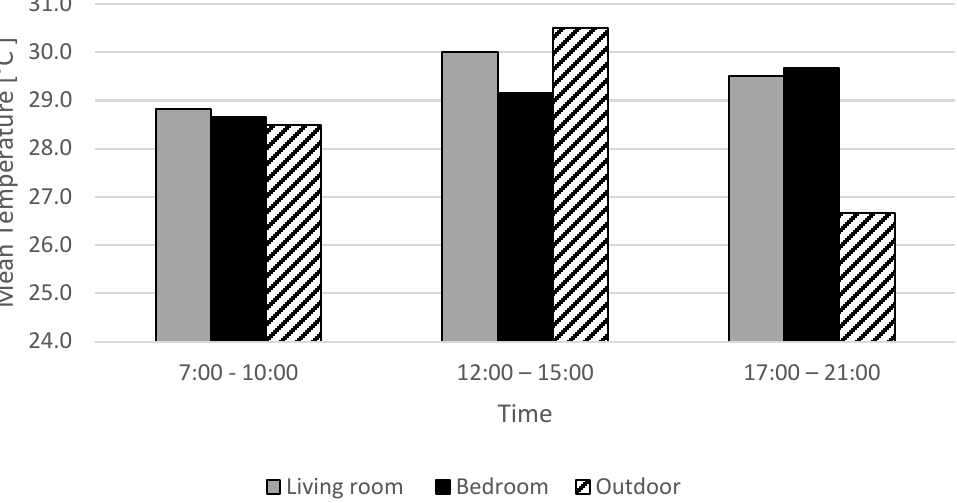
Figure 8. Temperature in the living room, bedroom, and outdoors as averaged over six days of measurements (HRB1).